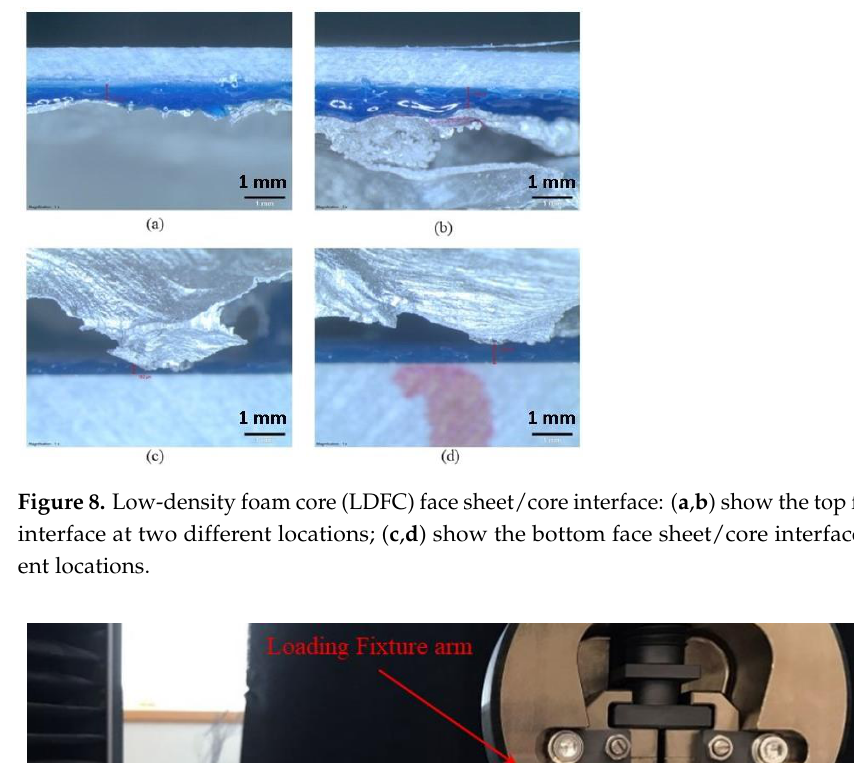
at two different locations.